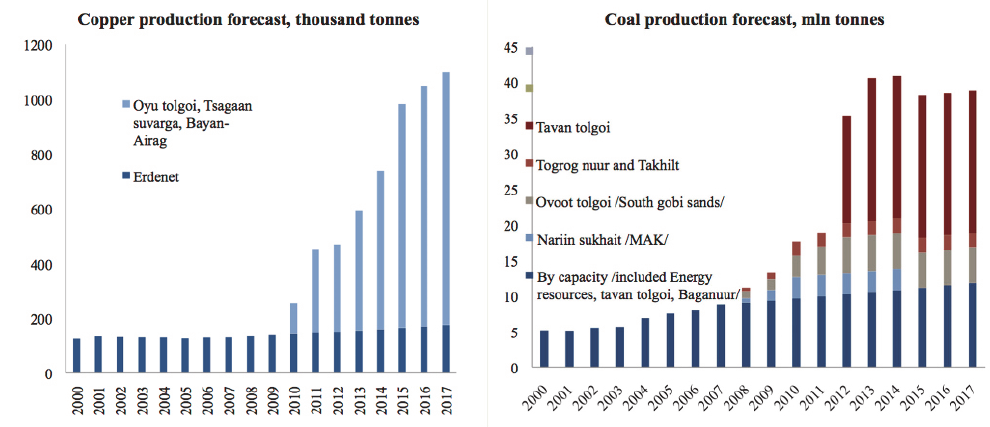
Fig. 1. P rojected production of copper and coal in Mongolia (National Statistical Office of Mongolia, 2015)